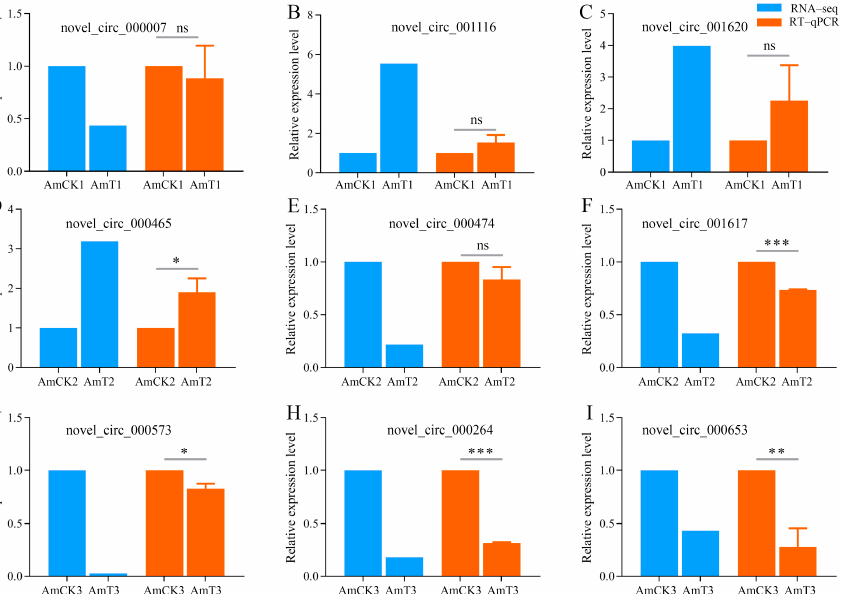
Figure 8. RT-qPCR validation of 9 DEcircRNAs. ns, p > 0.05; * p < 0.05; ** p < 0.01; *** p < 0.001. ( A – C ) Three DElncRNAs in AmCK1 vs AmT1 comparison group; ( D – F ) Three DElncRNAs in AmCK2 vs AmT2 comparison group; ( G – I ) Three DElncRNAs in AmCK3 vs AmT3 comparison group.